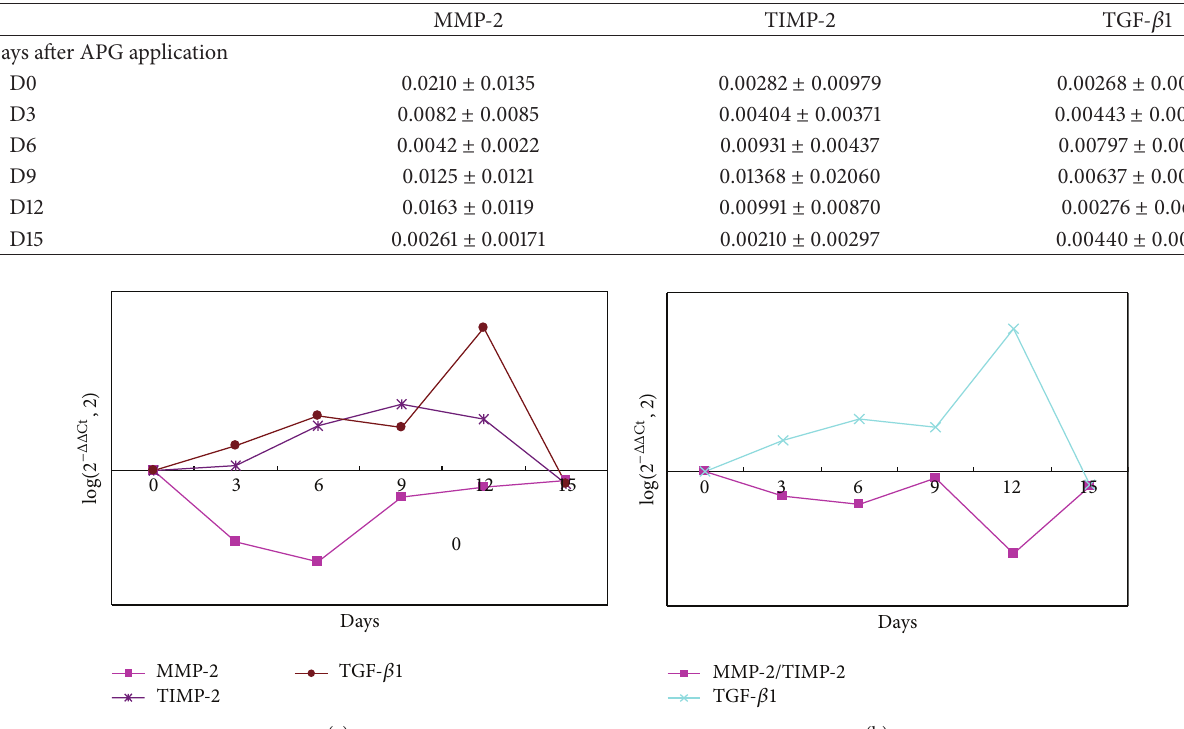
Table 2: Dynamic changes of the mean density (MD) of the MMP-2, TIMP-2, and TGF- 𝛽 1 in granulation tissue before and within 15 days after the APG application (IHC).